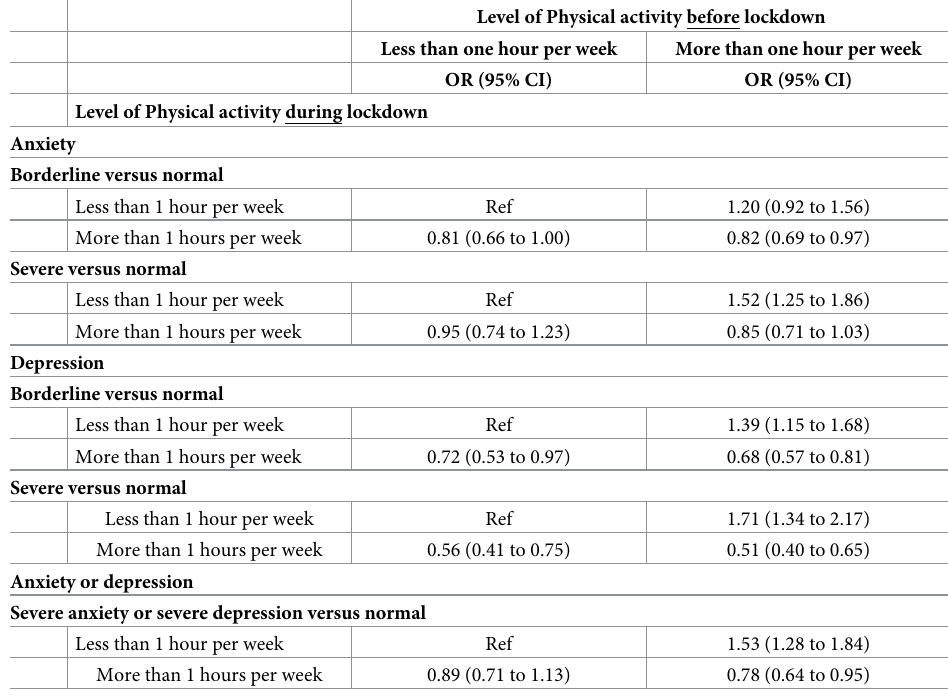
Table 4. Effect of physical activity on psychological distress: Odds ratio of being borderline versus normal and severe versus